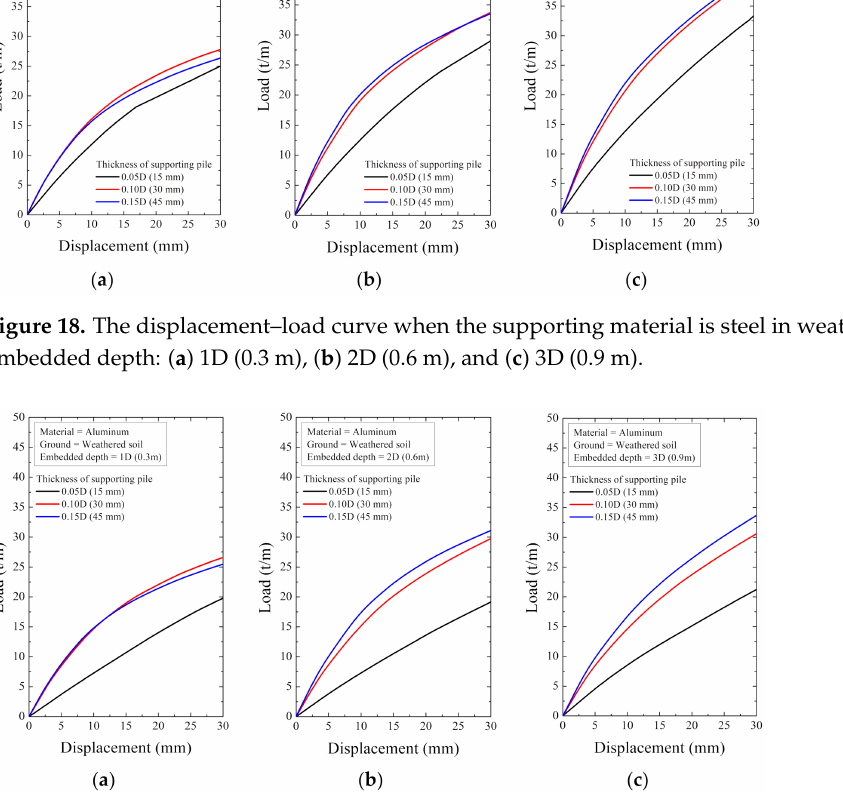
Figure 19. The displacement–load curve when supporting material is aluminum in weathered soil at